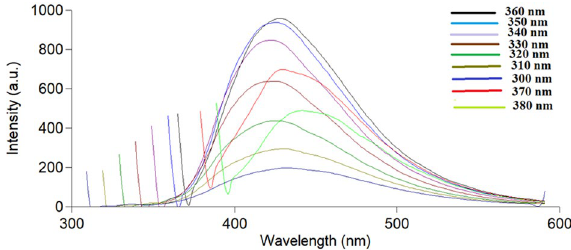
Figure 3. Fluorescence emission spectra of SN-CQDs at different excitation wavelengths (300–380 nm).